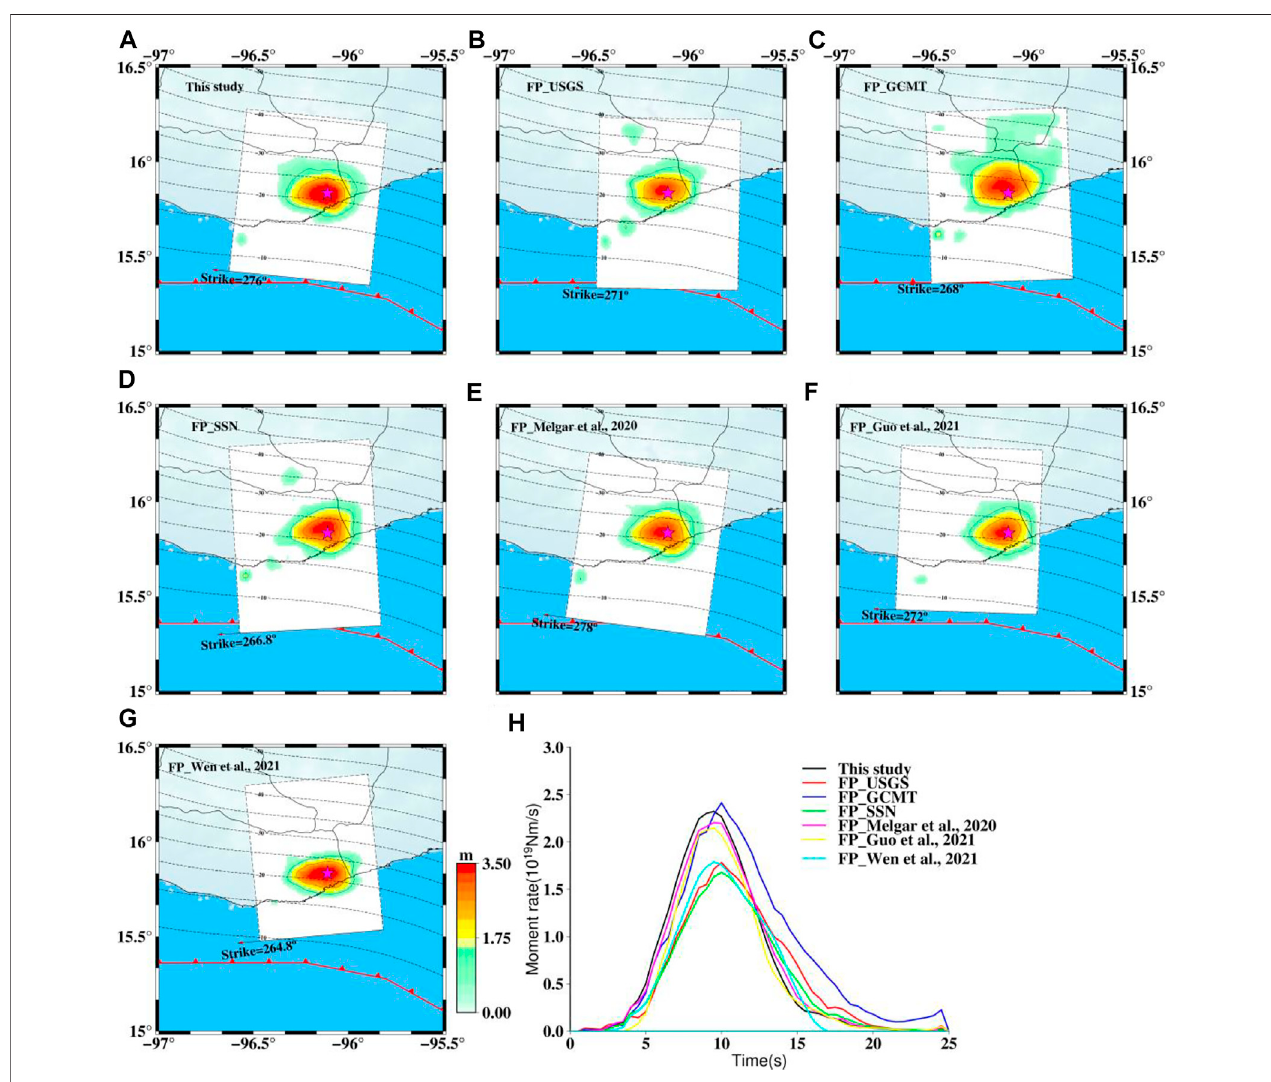
FIGURE 11 | Surfaceprojectionsoftheslipdistributionandsourcetimefunctions. (A-G) denotethesurfaceprojectionsoftheslipdistributionuseddifferentfaultplane [i.e. fault geometry from this study, USGS (FP_USGS), GCMT (FP_GCMT), SSN (FP_SSN)], Melgar et al. (2020) (FP_Melgar et al., 2020), Guo et al. (2021) (FP_Guo et al., 2021),andWenetal.(2021)(FP_Wenetal.,2021),respectively.Themagentastardenotestheepicentrallocation. (H) Sourcetimefunctionsderivedfromtheresultsof (A-G) .